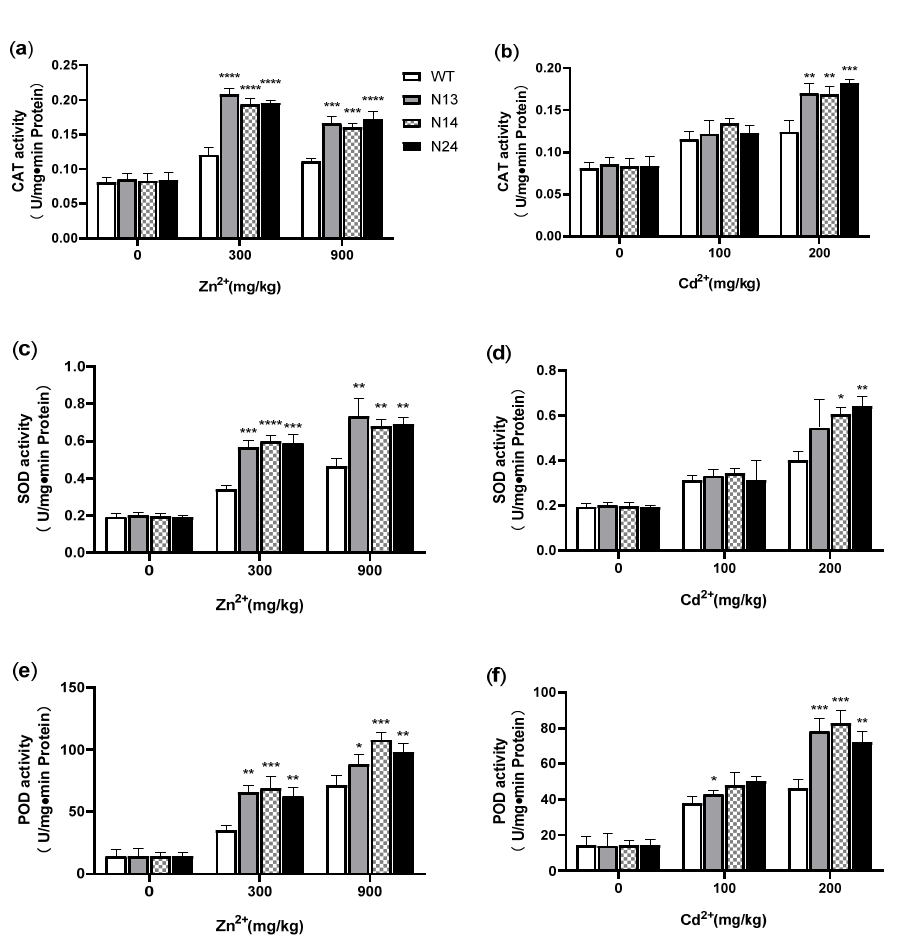
Figure 6. Comparison of antioxidant enzyme activities under Zn 2+ or Cd 2+ stress. ( a ) CAT activity of transgenic and WT tobacco under different concentrations of Cd 2+ . ( b ) CAT activity of transgenic and WT tobacco under different concentrations of Zn 2+ . ( c ) SOD activity of transgenic and WT tobacco under different concentrations of Zn 2+ . ( d ) SOD activity of transgenic and WT tobacco under different concentrations of Cd 2+ . ( e ) POD activity of transgenic and WT tobacco under different concentrations of Zn 2+ . ( f ) POD activity of transgenic and WT tobacco under different concentrations of Cd 2+ stress. WT: Wild ‐ type tobacco. N13, N14, N24: Three homozygous transgenic tobacco lines (T 2 ). The 4 − week − old WT and transgenic plants were treated under Zn 2+ (0, 300, or 900 mg/kg) or Cd 2+ (0, 100, or 200 mg/kg) for 3 weeks, respectively. Asterisks indicate the significant difference between transgenic lines and WT (*, p < 0.05; **, p < 0.01 ; ***, p < 0.001; ****, p < 0.0001).